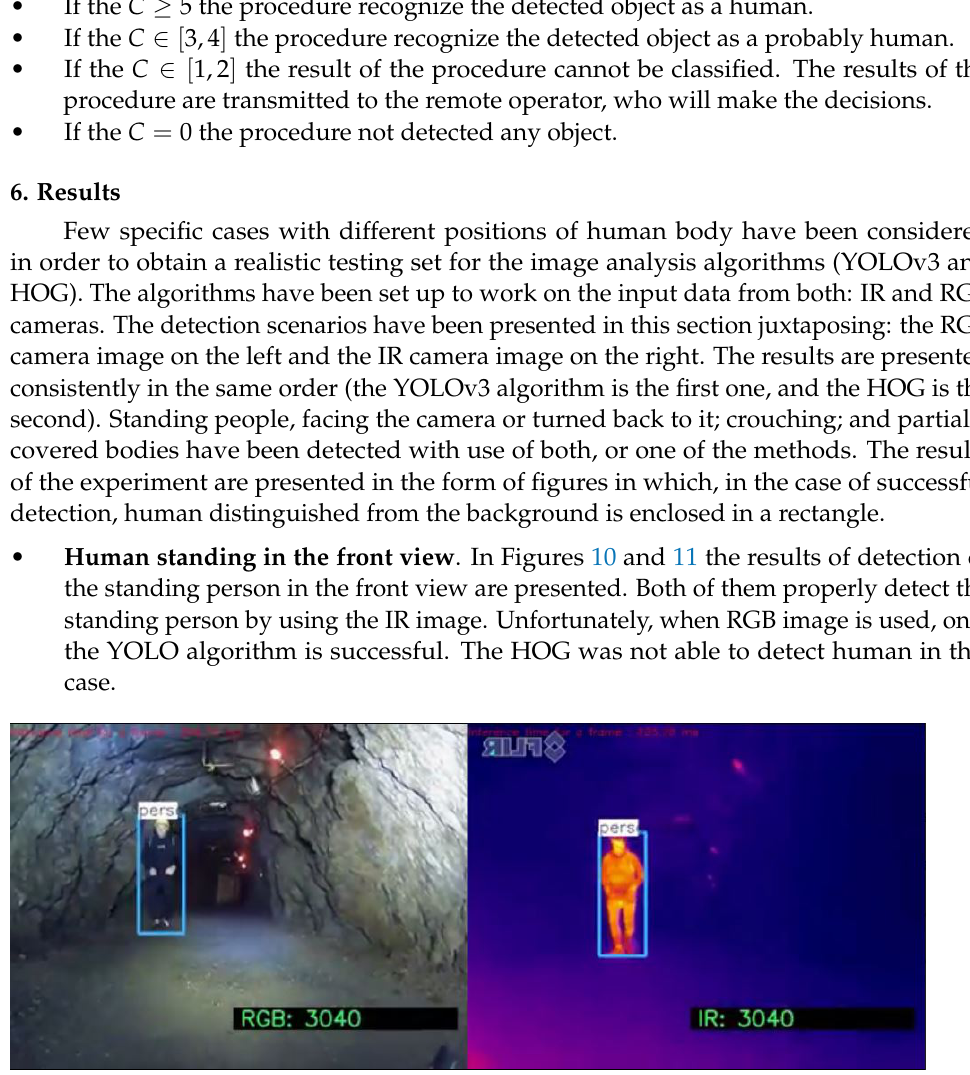
Figure 10. Human in standing position—correct detection with algorithm YOLO.